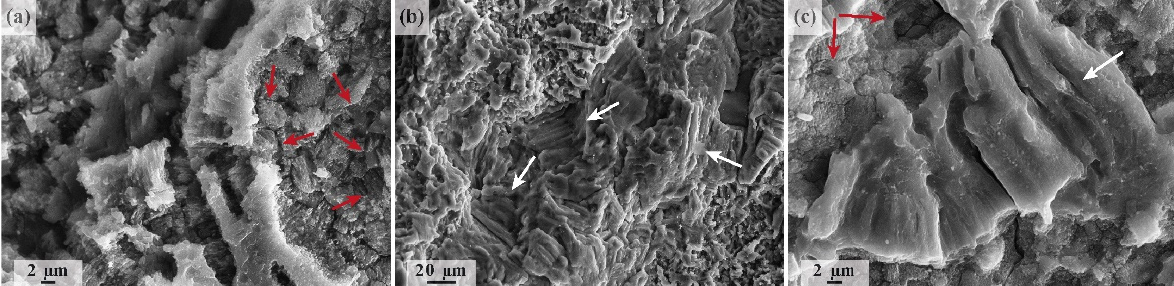
Figure 13. Enlarged fragments of the fracture surface after corrosion fatigue testing of ZK60 samples to failure at 50 MPa nominal stress amplitude and 10 Hz frequency, showing sporadically observed features that are typical of SCCs in many Mg alloys (including the same ZK60 [105]); red arrows point to the features characteristic of intergranular brittle fracture, and white arrows point to the fragments with a fluted fracture surface.